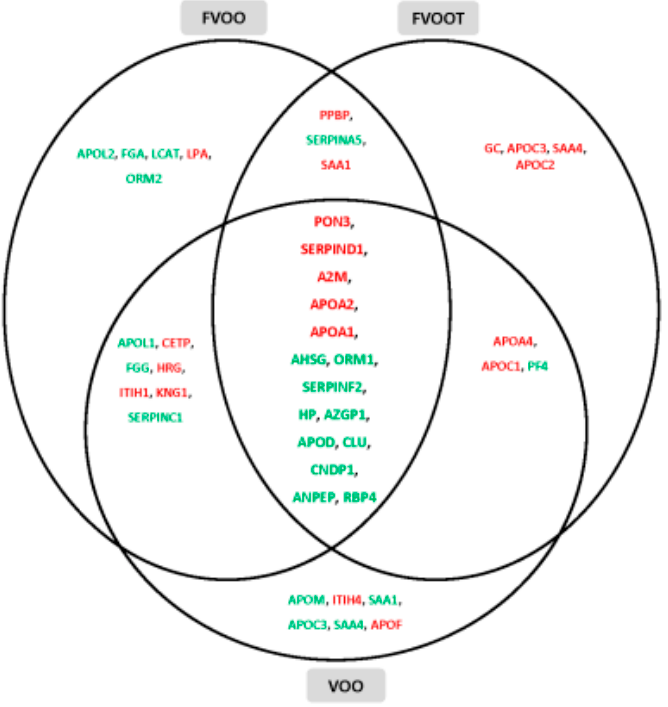
Figure 7. Venn diagram showing intersections of proteins differentially expressed after VOO, FVOO, and FVOOT interventions. Proteins are presented with their gene encode symbol. Red proteins: Up-regulated; Green proteins: Down-regulated. Figure reproduced with permission from Pedret et al. [100]. VOO: Virgin olive oil; FVOO: Functional virgin olive oil enriched with its own phenolic compounds; FVOOT: Functional virgin olive oil enriched with its own phenolic compounds plus complementary phenols from thyme.